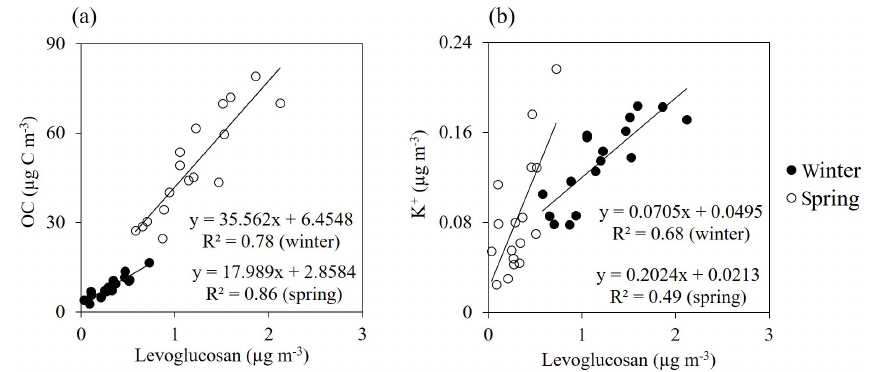
Figure 7. Correlations of PM 2 . 5 concentrations (µgm − 3 ) of mannosan and galactosan with levoglucosan during winter (a) and spring (b) of 2017.